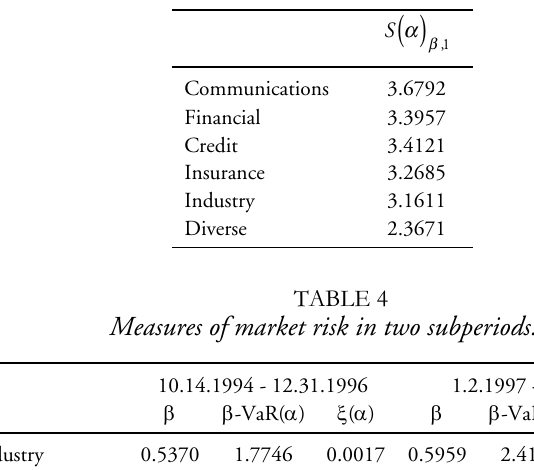
Rank of the restricted expected shortfall of the various asset categories for returns above the β -VaR